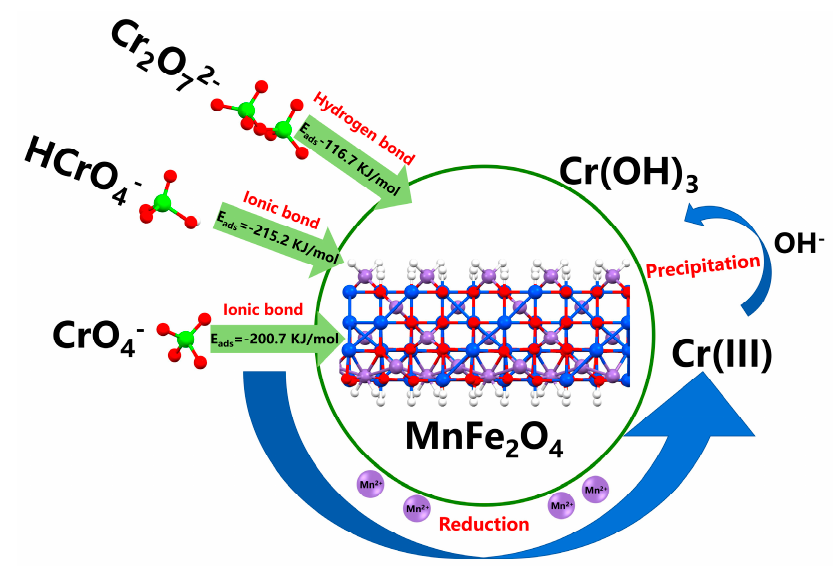
Figure 11. The diagram of the Cr(VI) adsorption and reduction processes.